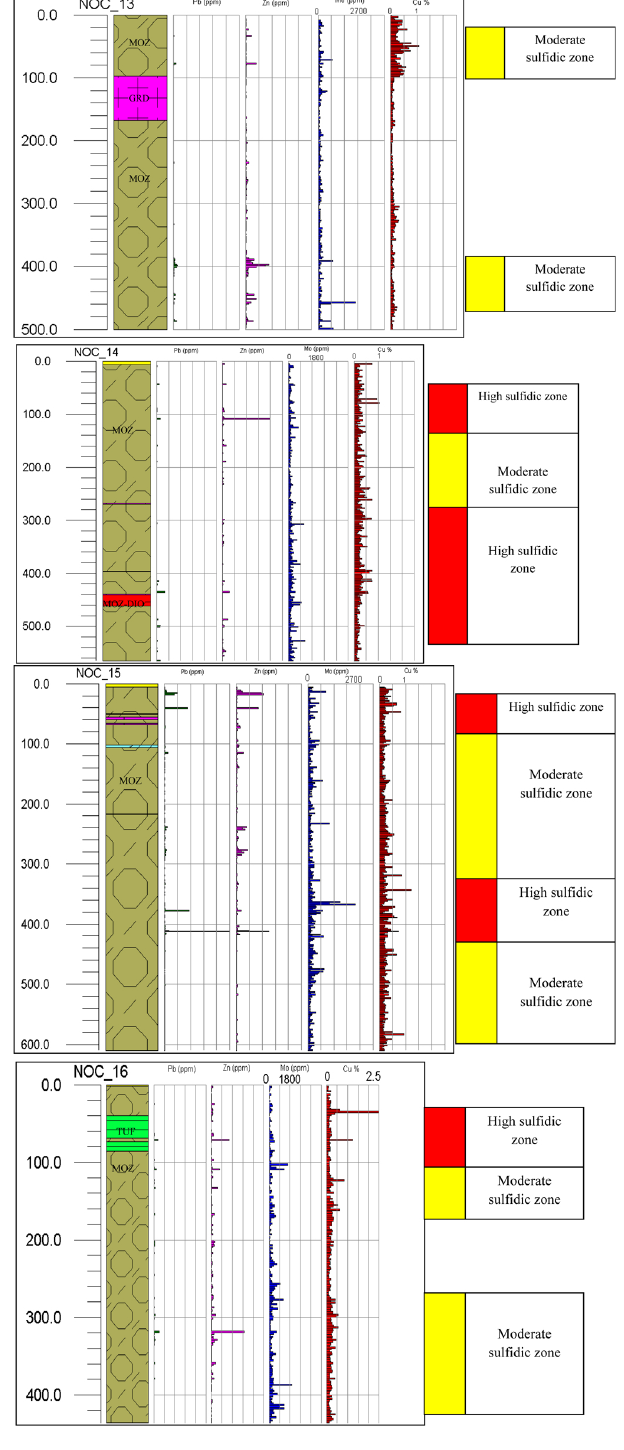
Fig. 5. Log sheets of NOC 13, NOC 14, NOC 15 and NOC 16 in Nowchun deposit and comparison between elemental grades and sulfidic zones derived via the C - V